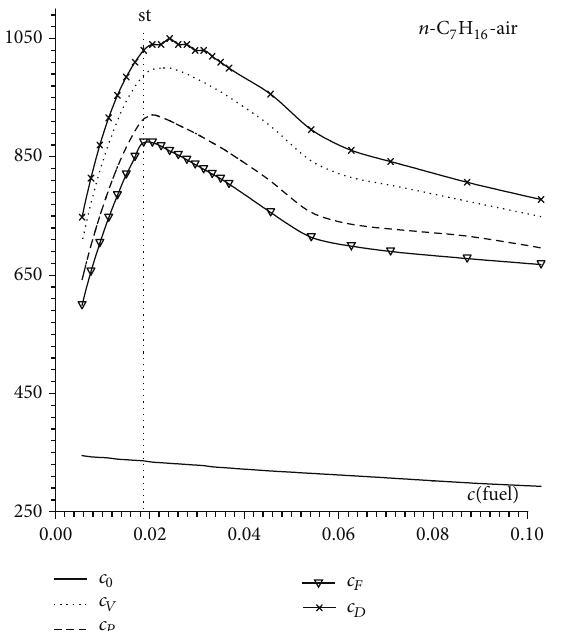
Figure 2: Sound velocities on fuel molar concentration for typical regimes of heptane-air mixtures (indexes correspond to character- istic points on Figure 1, vertical dotted line: stoichiometry).